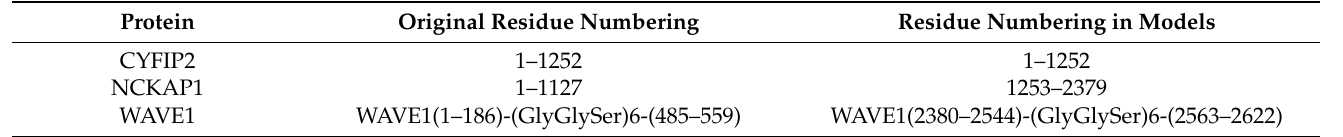
Table 1. Original residue notation compared to notation in our